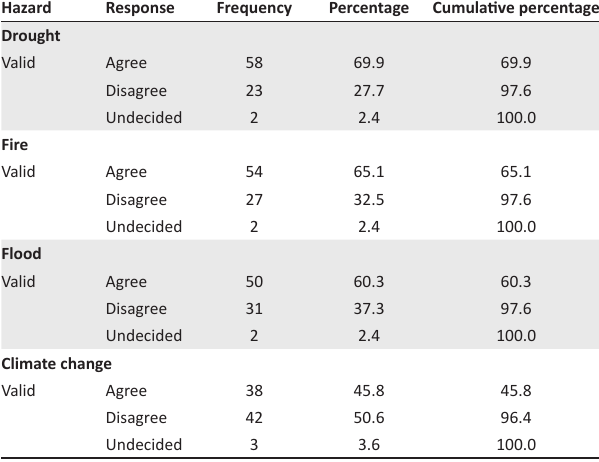
TABLE 8: Management of private wetlands to reduce disaster risks. Hazard